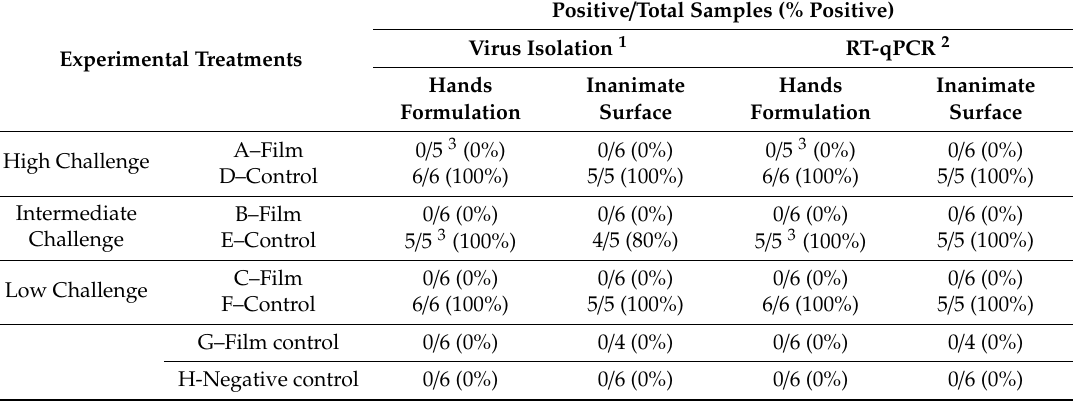
Table 2. Qualitative results of embryonated chicken eggs from di ff erent experimental groups obtained from avian coronavirus (ACoV) isolation and